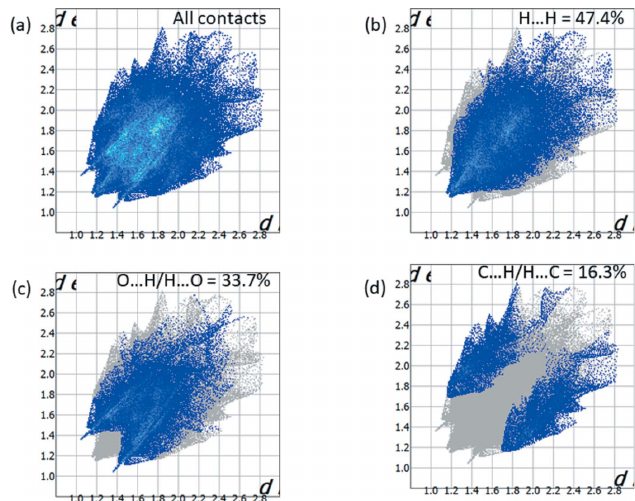
Figure 7 Two-dimensional fingerprint plots for the compound 7 C( R , R , S ) showing ( a ) all interactions, and delineated into ( b ) H (cid:3)(cid:3)(cid:3) H, ( c ) O (cid:3)(cid:3)(cid:3) H/H (cid:3)(cid:3)(cid:3) O, and ( d ) C (cid:3)(cid:3)(cid:3) H/H (cid:3)(cid:3)(cid:3) C